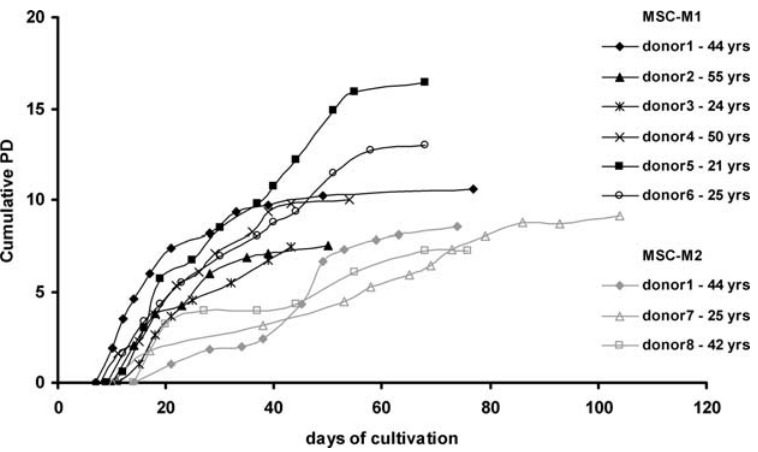
Figure 1. Long-term growth curves. Long-term growth curves are demonstrated for six MSC preparations isolated under culture conditions M1 and for three MSC preparations isolated under culture conditions M2. Cell numbers were determined at the end of every passage and cumulative population doublings (PD) were calculated in relation to the cell numbers at the first passage. The age of each donor is provided.